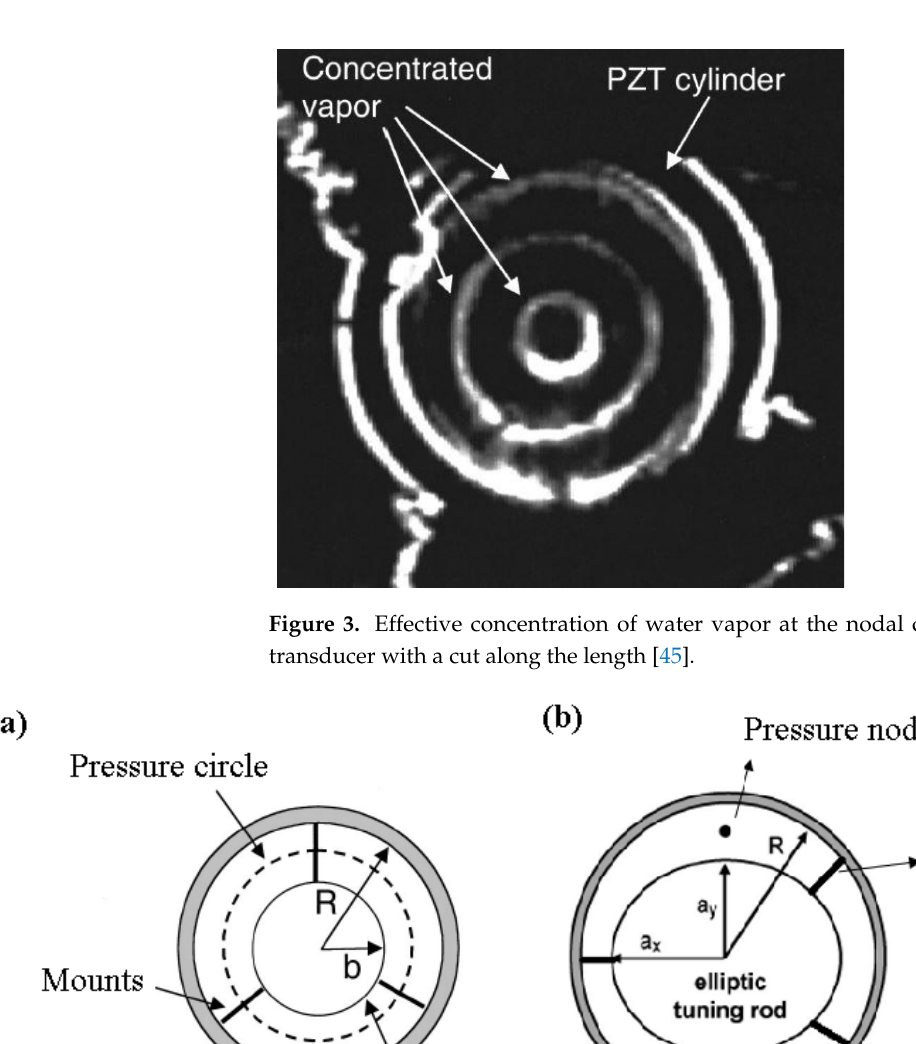
Figure 3. Effective concentration of water vapor at the nodal circles inside the PZT cylindrical transducer with a cut along the length [45].